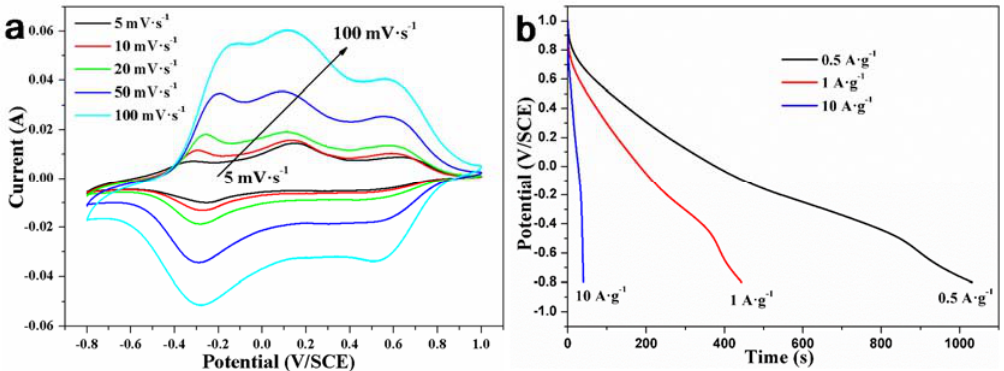
Figure 7. ( a ) CV curves of VO 2 (B) nanobelts; ( b ) GCD curves of VO 2 (B) nanobelts (1 M Na 2 SO 4 electrolyte).